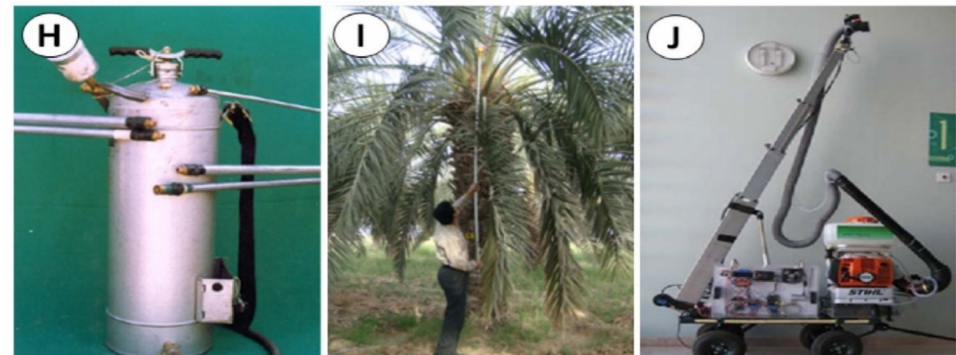
Figure 6. Date palm pollination methods using liquid and dry pollen. ( A ) Hand pollination with liq- uid suspension. ( B ) Pollination with a liquid suspension using a mechanism mounted on a tractor for high pressure delivery. ( C ) Inflorescence before and after liquid pollination. ( D , E ) Manual machines for pollination with dry DPP. ( F ) Pollination machine with a hydraulic mechanism. ( G ) Motorized duster. ( H ) Pressurized sprayer. ( I ) Palm pollination using an electric pollinator. ( J ) Prototype of a pollinating robotic arm using artificial intelligence. Source: Images A, B, D, E, G (Adapted from [16]). Image C (Photo by Ricardo Salom ó n-Torres). Image F (courtesy of Agrom Agricultural Machinery, LTD, www.agrommachine.com; accessed on 22 July 2020). Images H, I, J (Adapted from